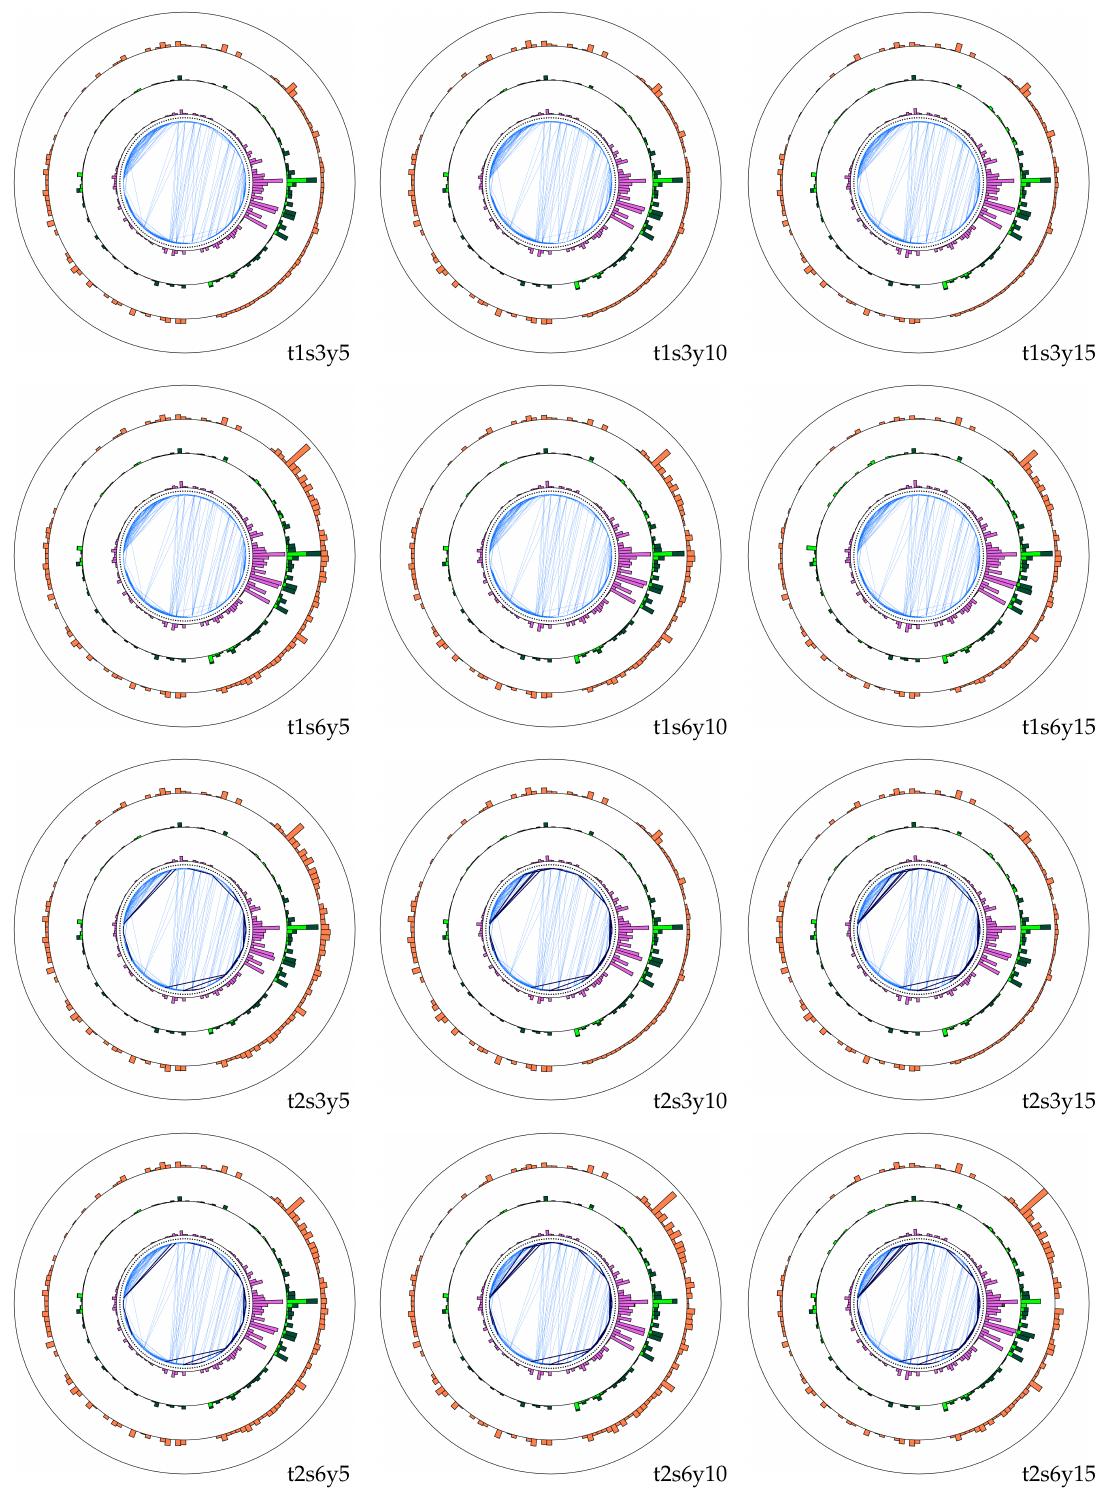
Figure 6. High-quality scenarios for Transmission Plans 1 (t1) and 2 (t2), under Scenarios 3 (s3) and 6 (s6), and for Years 5 (y5), 10 (y10), and 15 (y15). Dark purple is used to indicate load shedding. The selected scenarios for two different plans are different because their power system structures are different. Hence, the iterative approach results in different high-quality scenarios for two different